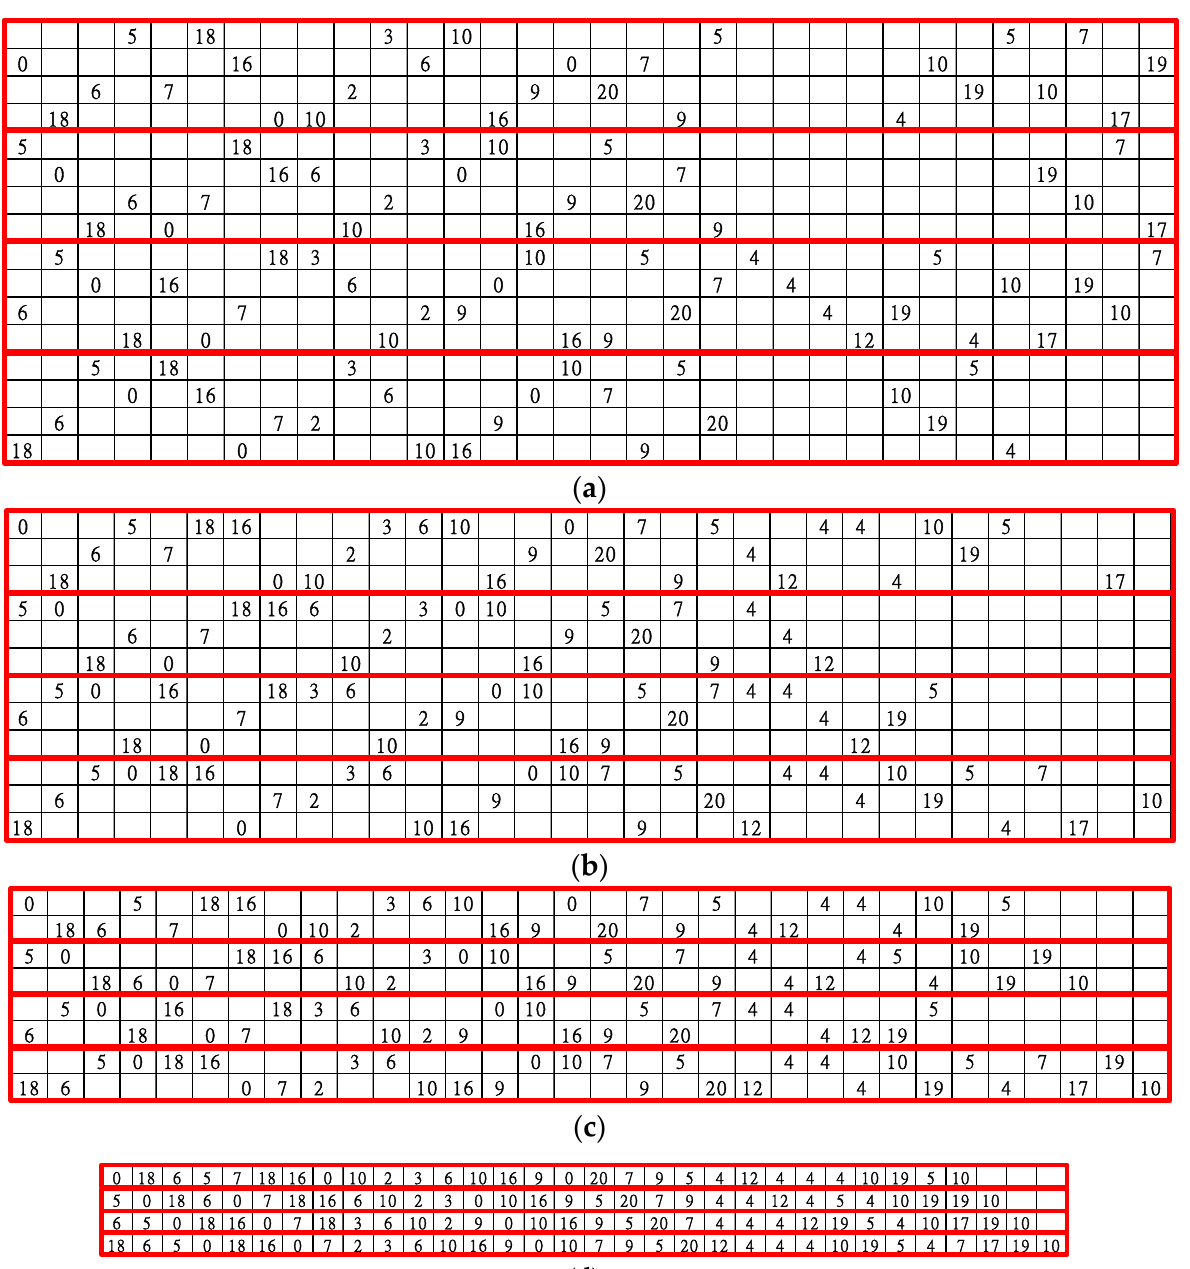
Figure 6. IEEE 802.11ad parity check matrix with R = ( a ) 1/2, ( b ) 5/8, ( c ) 3/4, and ( d ) 13/16.